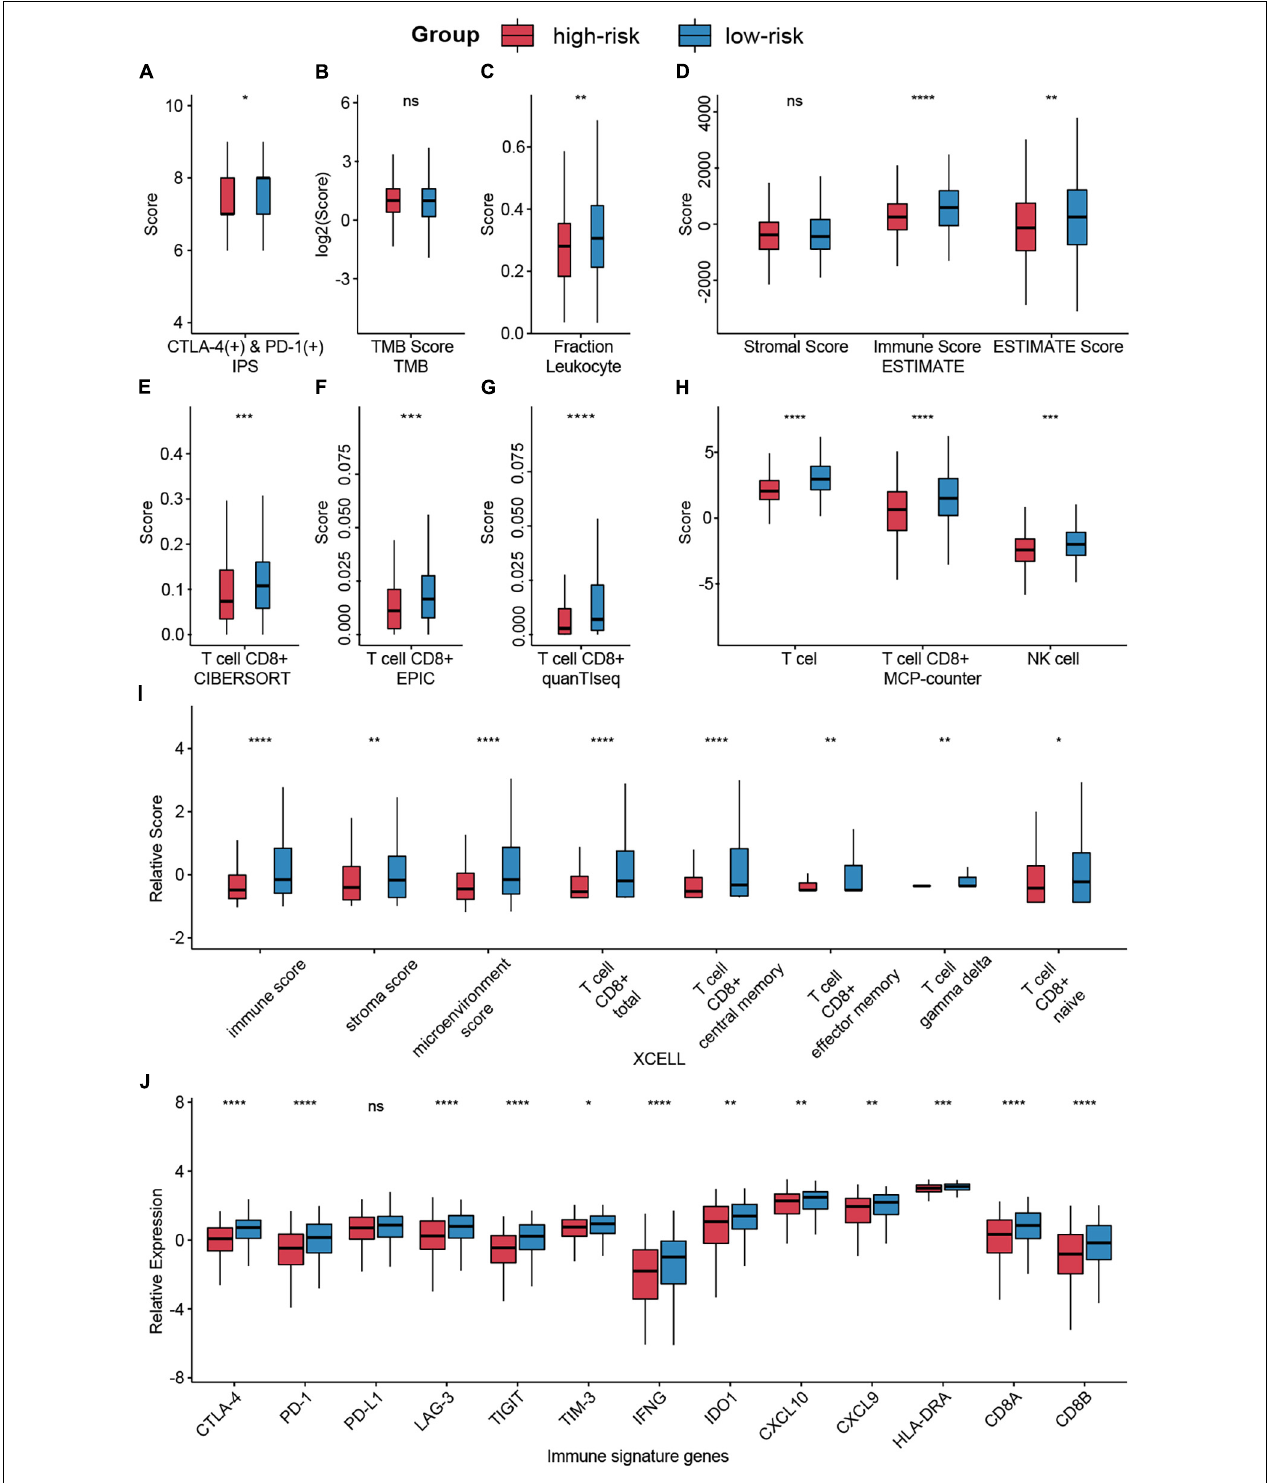
FIGURE 6 | Analysis of immunotherapy responses in different risk groups. (A) The relationship between the risk groups and IPS. (B) TMB in different risk groups. (C,D) Leukocyte fraction and ESTIMATE score indicated that immune cells were highly enriched in the low-risk group. (E–I) Infiltrating immune cell in different groups was calculated by CIBERSORT, EPIC, quanTIseq, MCP-counter, and XCELL. (J) Expression levels of immune signature genes in different groups were exhibited by box plot. Ns: not significant, * p < 0.05, ** p < 0.01, *** p < 0.001, **** p < 0.0001.